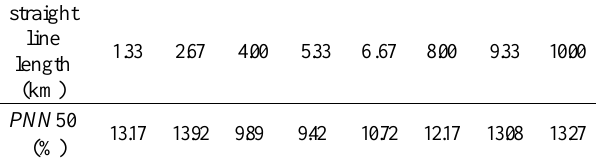
Tab.9. Data of straight line length and